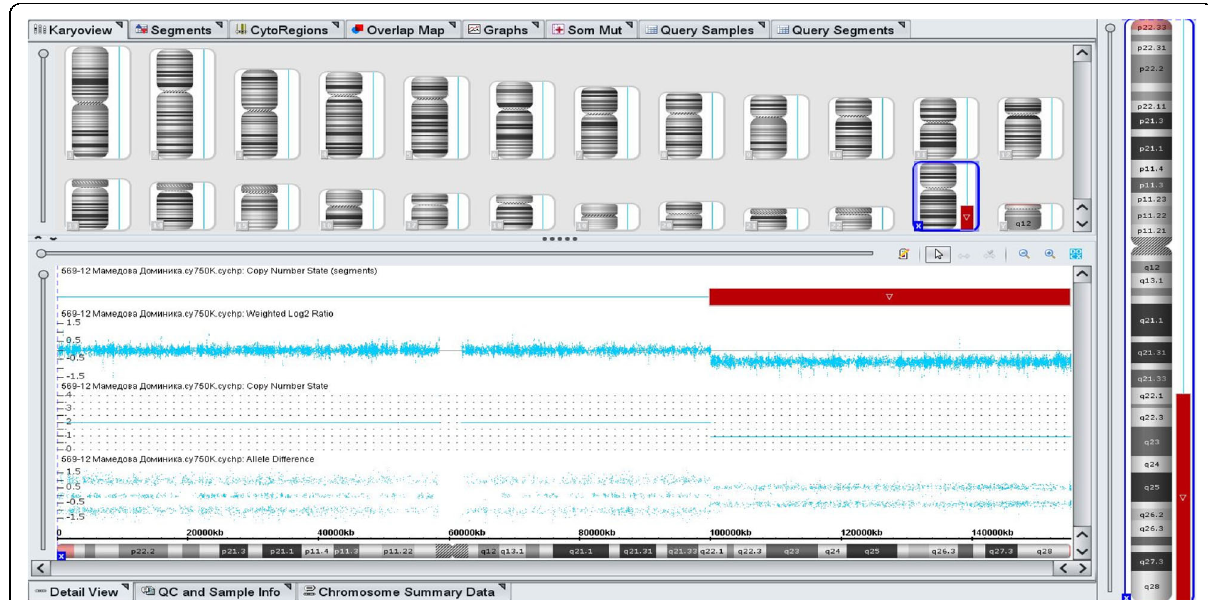
Fig. 5 The result of micro-matrix analysis. A deletion of the long arm (q) of chromosome X from position 100,028,096 to position 155,233,098, capturing regions Xq22.1-q28, was detected. Size: 55205002